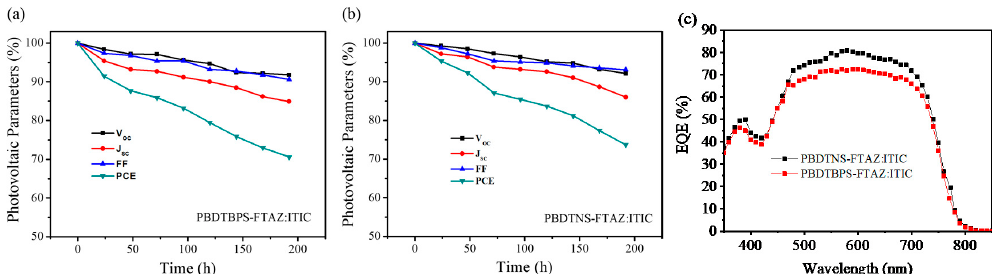
Figure 4. ( a , b ) Normalized photovoltaic parameters aged in air for 192 h; ( c ) external quantum efficiency (EQE) spectra of devices based on PBDTNS-FTAZ and PBDTBPS-FTAZ.